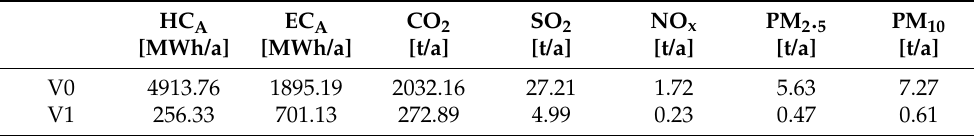
Figure 8. CO 2 emission maps for the Smulsko cluster before (on left ) and after (on right ) modernization. Table 2. An energy-related summary for the Smulsko cluster. Table 2. An energy-related summary for the Smulsko cluster.